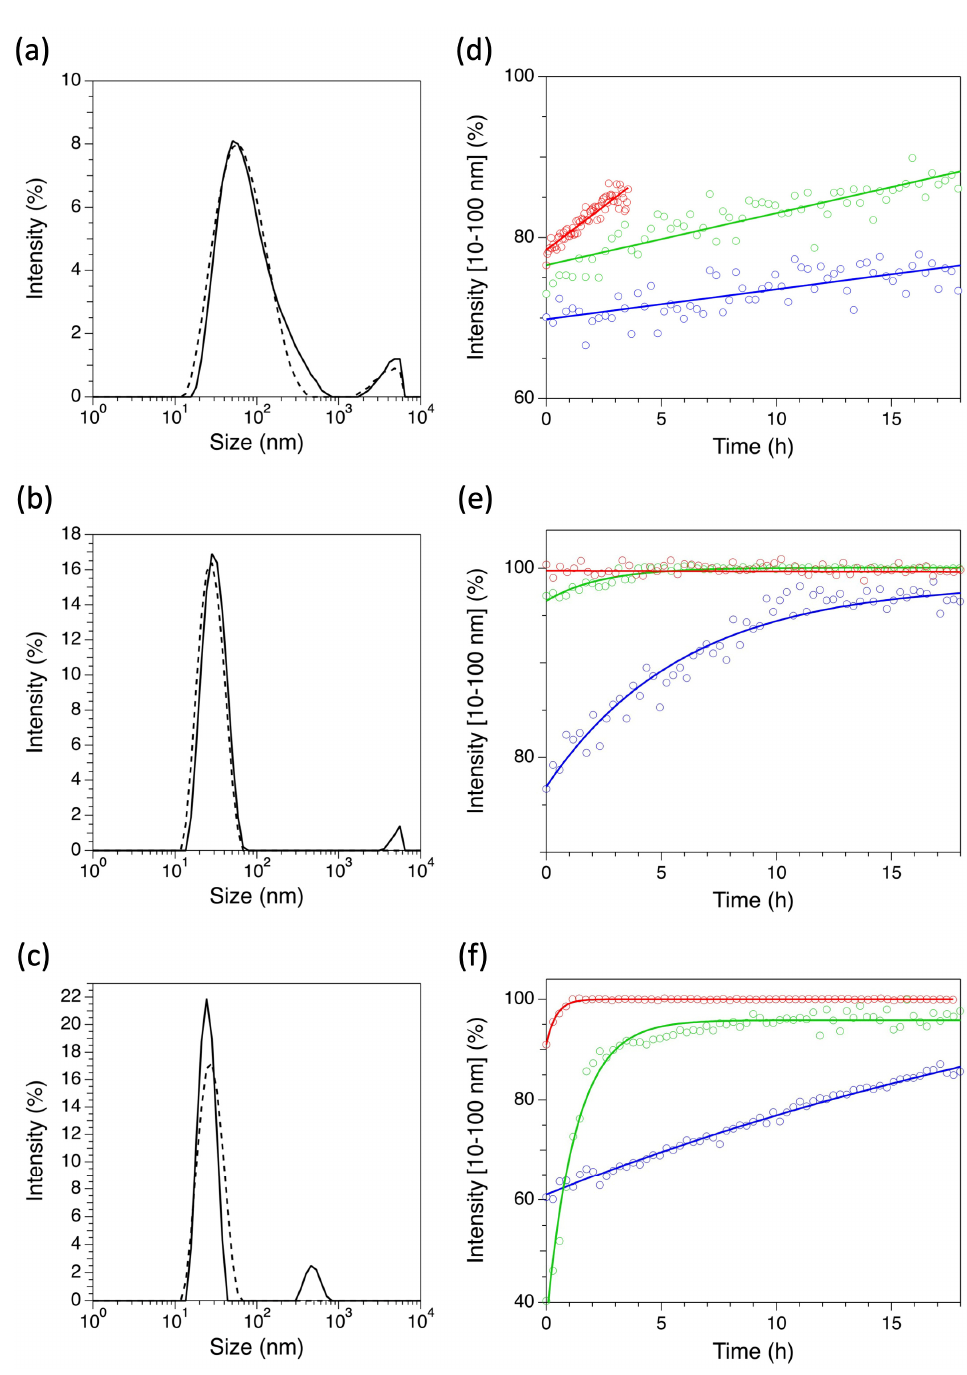
Figure 2. ( a – c ) DLS intensity plots of sc- I ( a ), sc- II ( b ), and sc- III ( c ) immediately after mixing (solid line) and after 18 h (dashed line) at 37 °C. ( d – f ) Relative DLS intensity (range 10–100 nm) plots after mixing equimolar solutions of copolymers I -L + I -D ( d ), II -L + II -D ( e ) and III -L + III -D ( f ) at 25 °C (blue circles), 37 °C (green circles), and 50 °C (red circles); solid lines represent linear ( d ) or exponential ( e , f ) fits to datasets. All experiments were carried out in PBS using 0.3 wt.% of L and D copolymers.